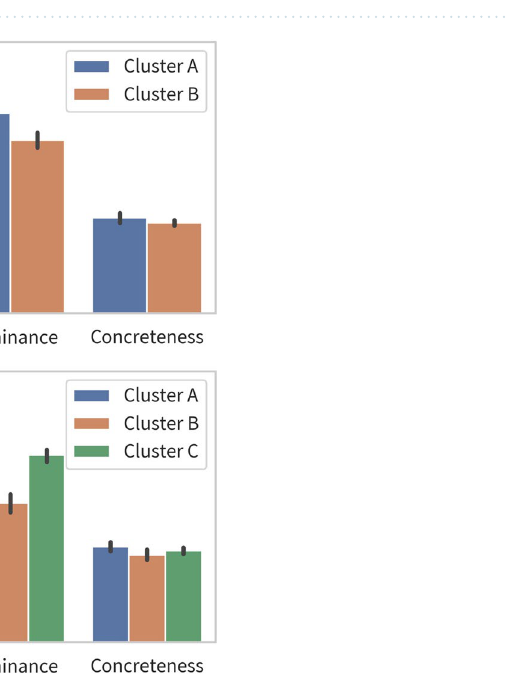
Figure 2. Hierarchical clustering based on the original ratings of valence, arousal, dominance and concreteness using Euclidean distance and Ward linkage function. ( a ) Silhouette coefficients by number of clusters. Two- cluster is the optimal number of clusters. ( b ) Dendrogram with two-cluster and three-cluster cut points, dash line is two-cluster and solid line is three-cluster.